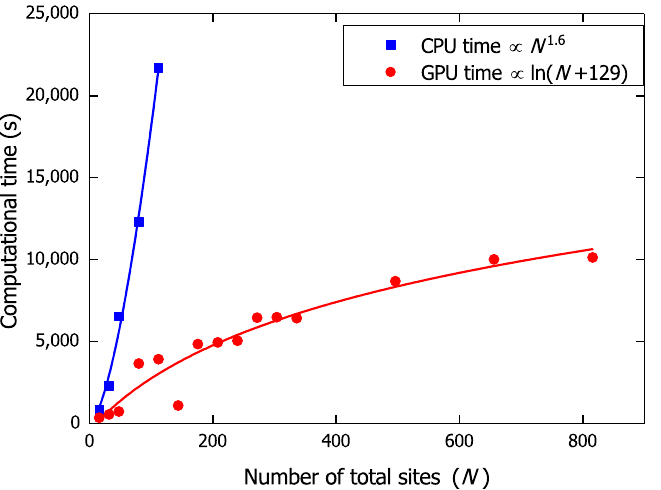
Figure 3. Computational time of CPU and GPU for different size of systems. The blue line is the power law fitting for the CPU time and the red line is the logarithmic fitting of the GPU time. The fitting parameters are shown in the legend with N being the total number of sites in the system.